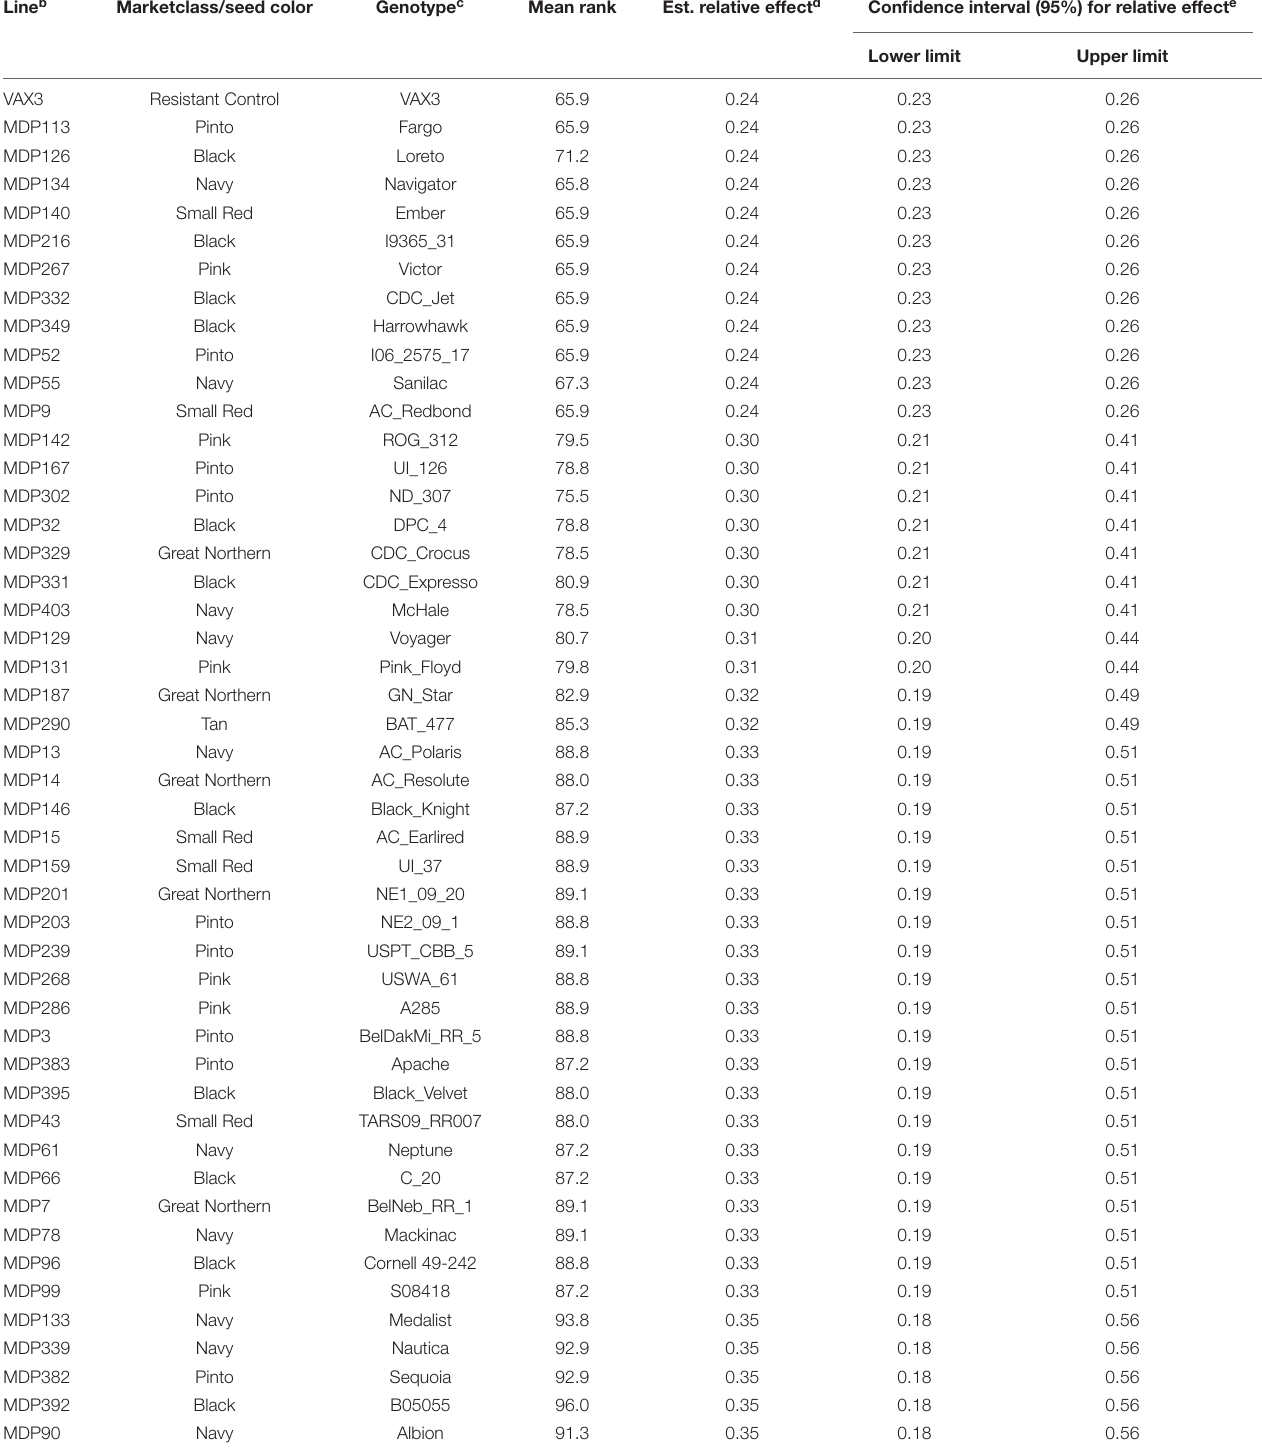
TABLE 3 | Common bean lines from the Middle American Diversity Panel (MDP) classified as resistant as compared to the resistant control VAX3 based on overlapping confidence intervals and P- values ( α < 0.05) a . Line